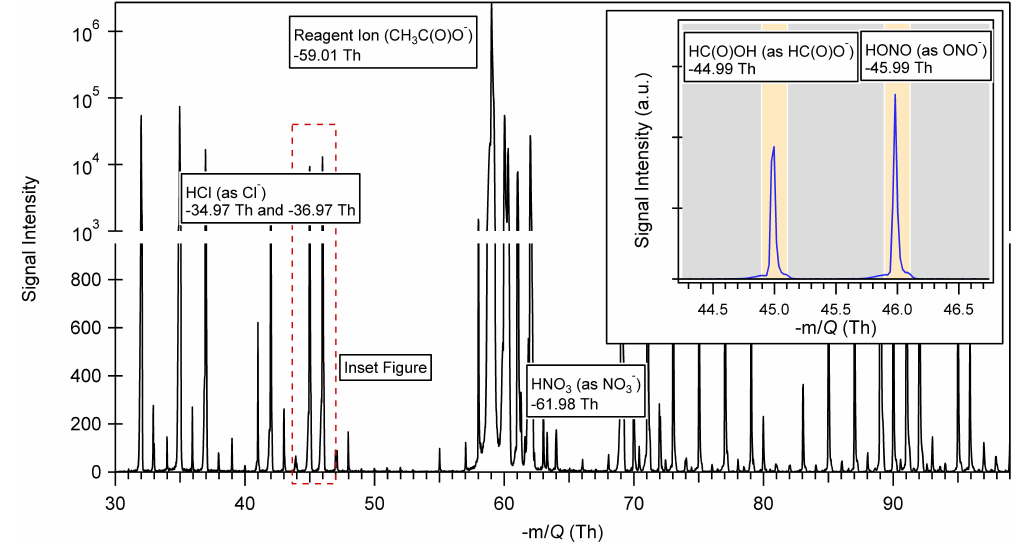
Fig. 3. Negative ion CI-TOFMS mass spectrum, acquired at 2Hz using acetate (CH 3 C(O)O − ) reagent ions. The spectrum was taken on ambient air measured aboard the R/V Atlantis during the CalNex Campaign in May 2010. Inset figure Formic and nitrous acid peaks, observed at − 44.99Th and − 45.99Th, respectively. The yellow shaded region represents the UMR peak integration window, and the grey shaded region the background determination window. The resolving power ( M / 1M ) at − 44.99Th is 900ThTh − 1